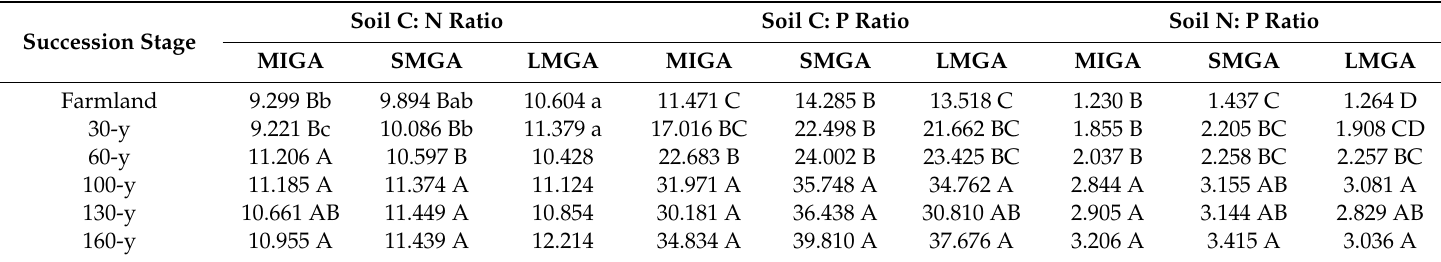
Table 2. E ff ects of di ff erent particle size aggregates on topsoil stoichiometry in di ff erent succession stages.